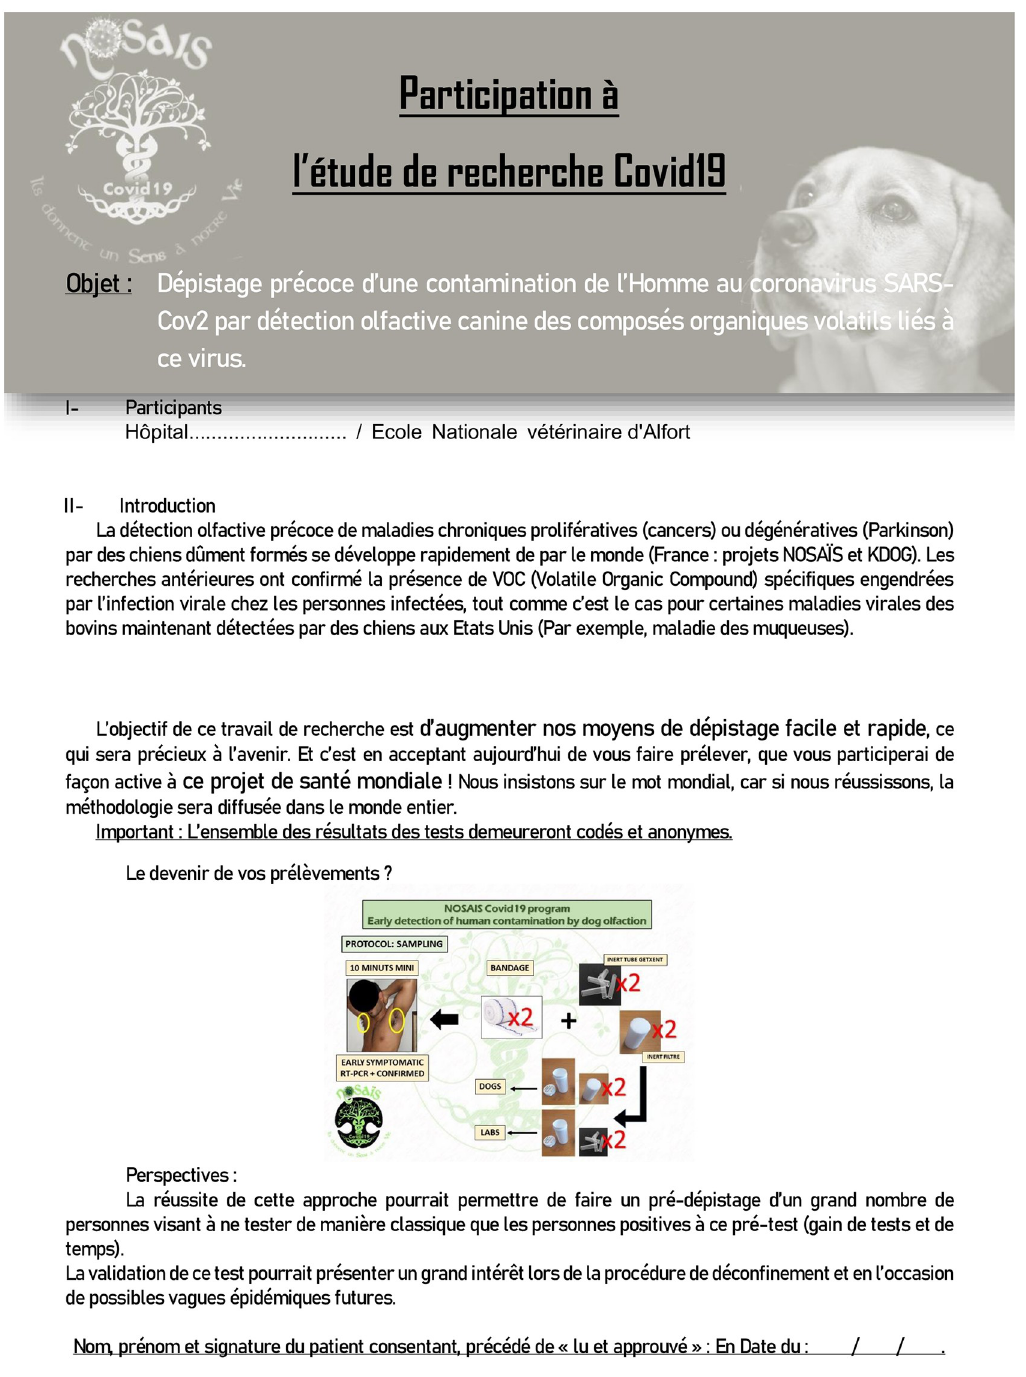
Fig 1. Individual informed consent